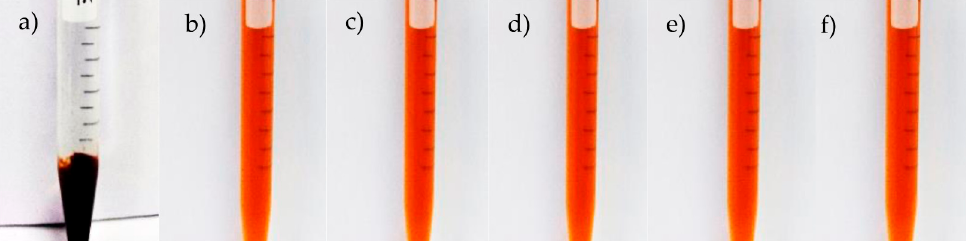
Figure 1. Visual confirmation of ( a ) unmodified iron hydroxide nanoparticles. ( b ) Fe:GA (1:0.25) ( c ) Fe:GA (1:0.5), ( d ) Fe:GA (1:1), ( e ) Fe:GA (1:1.5), and ( f ) Fe:GA (1:2).